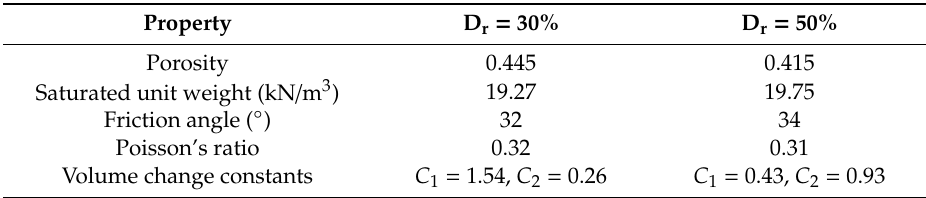
Table 4. Input properties of the model soil for parametric